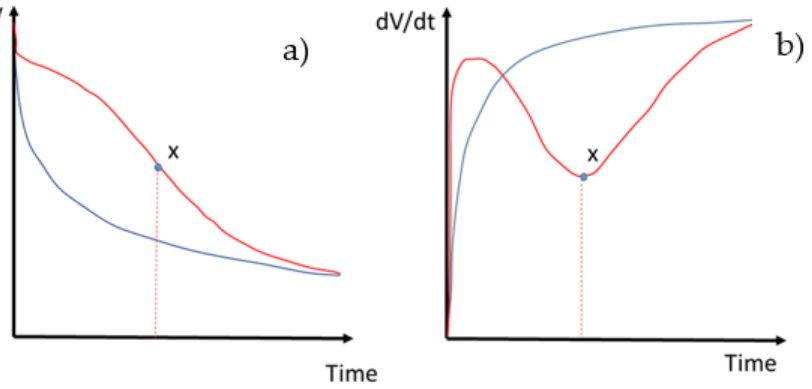
Figure 2. ( a ) Voltage relaxation with Lithium plating (red line) and without Lithium plating (blue line). ( b ) Differential voltage during the relaxation period with Lithium plating (red line) and without Lithium plating (blue line).